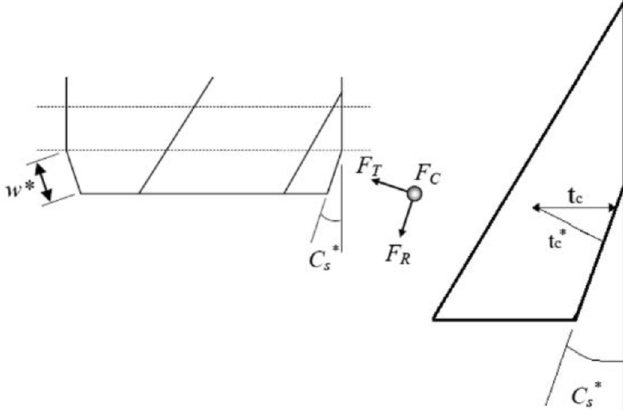
Fig. 2. Schematic of the transformation from 3D milling to 2D